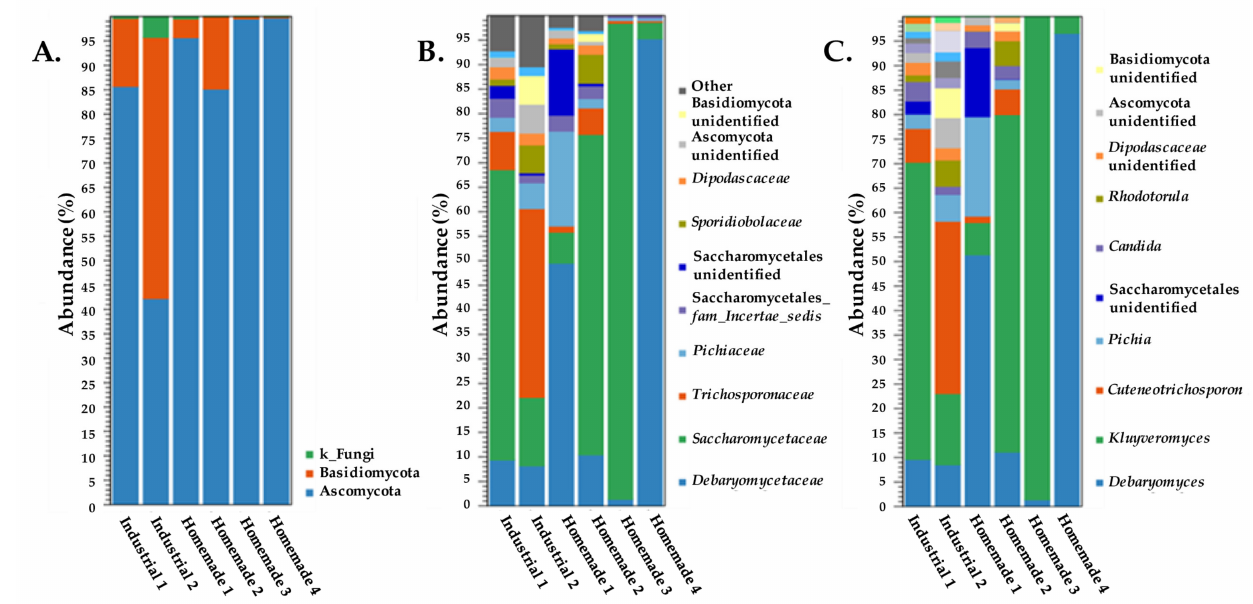
Figure 3. Taxonomic profile of industrial and homemade Feta cheese samples based on ITS amplicon data. Taxa were clustered at the phylum ( A ), family ( B ), and genus ( C ) levels. Panel ( C ) presents genera with abundance ≥